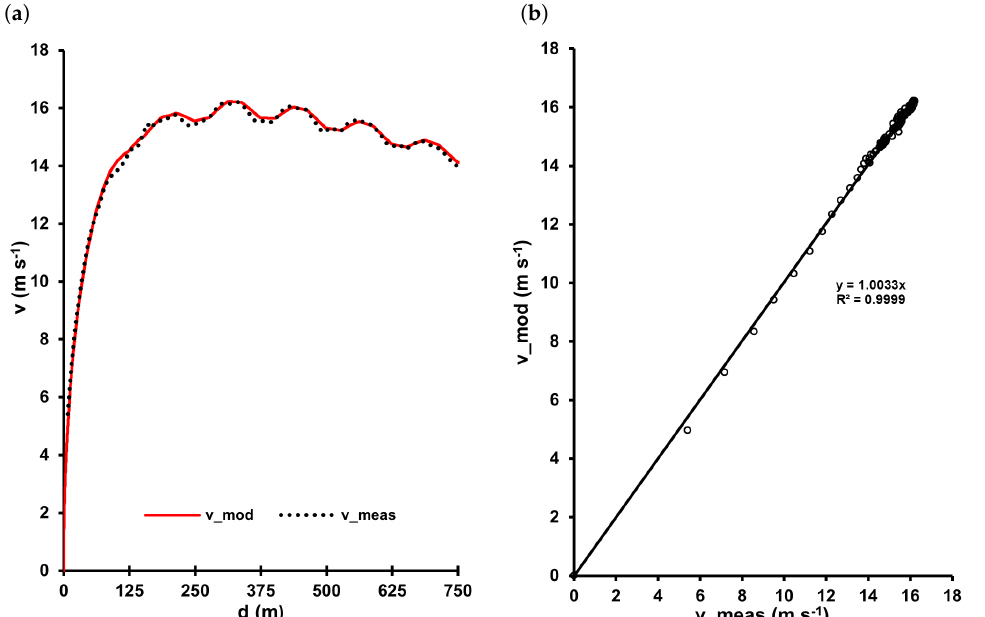
Figure 5. Comparison of measured and modelled velocity v w in the first run of a 750 m-time trial. ( a ) Measured and modelled data, ( b ) linear regression analysis.